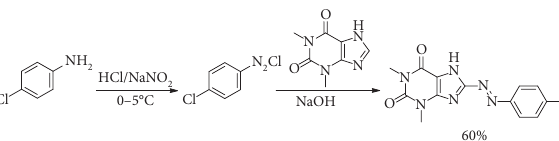
Scheme 1: Preparation steps of CPAT azo dye of